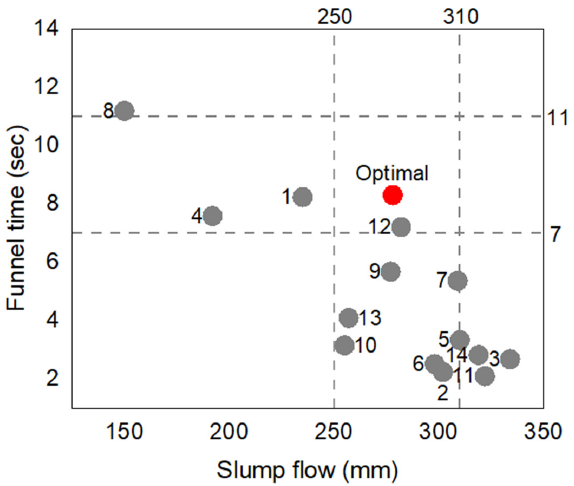
Figure 4. Workability box of self-compacting mortar. Gray dots represent the experimental values of 14 designed experiments. The red dot represents the experimental result of the optimized solution.